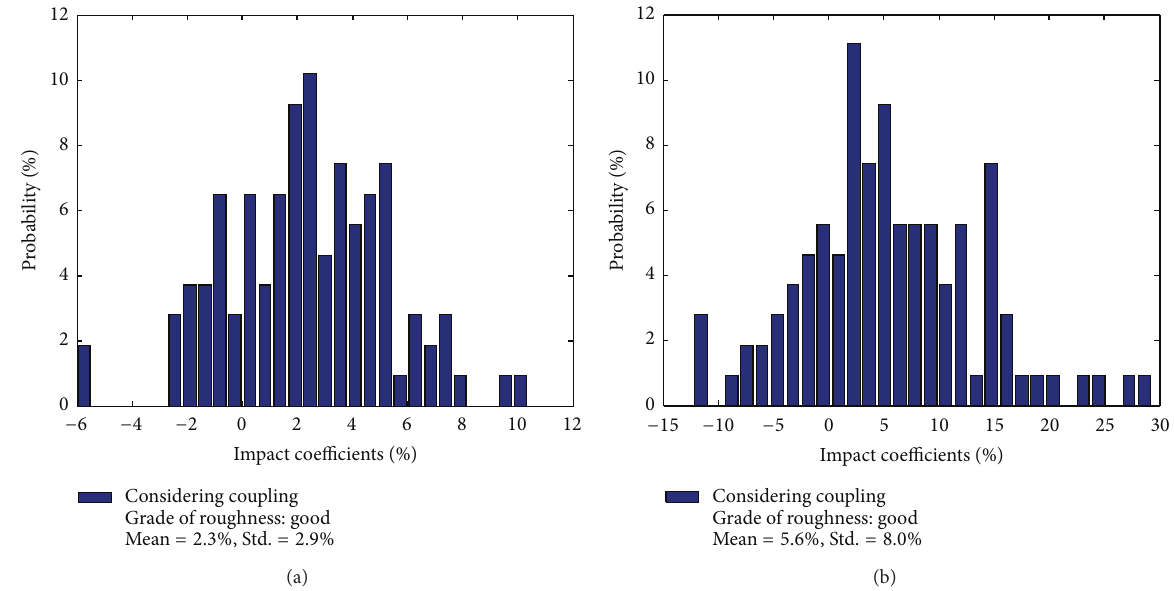
Figure 20: Probabilistic distributions of vertical moment impact coefficients at point C of the bridge in a windy environment: at the mean wind velocity of (a) 30 m/s; (b) 49.8